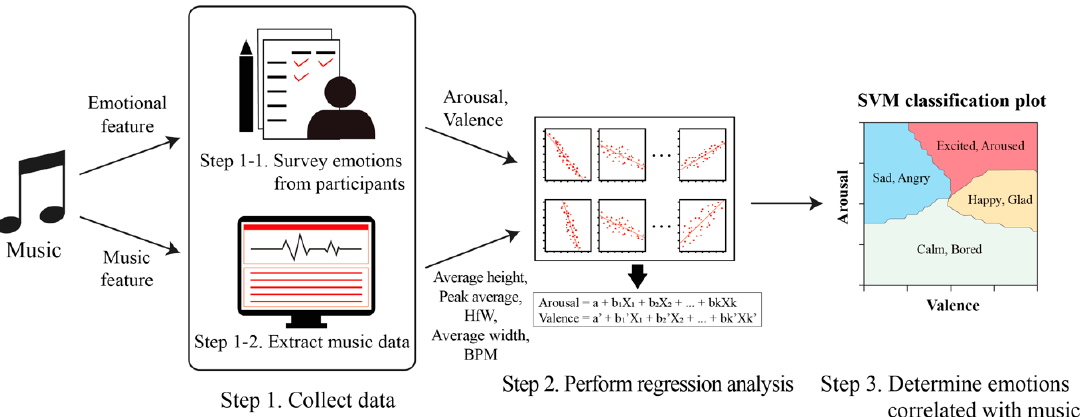
F igure 4. Hyperplane and margin of SVM.